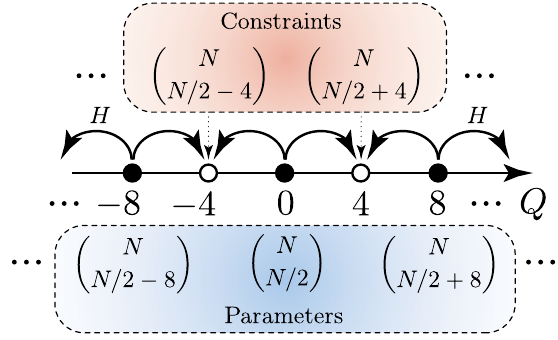
24. This picture represents the counting of zero-energy ˜ Q ¼ 0 sector. They are superpositions of states with states in the charges Q ¼ 0 mod 8